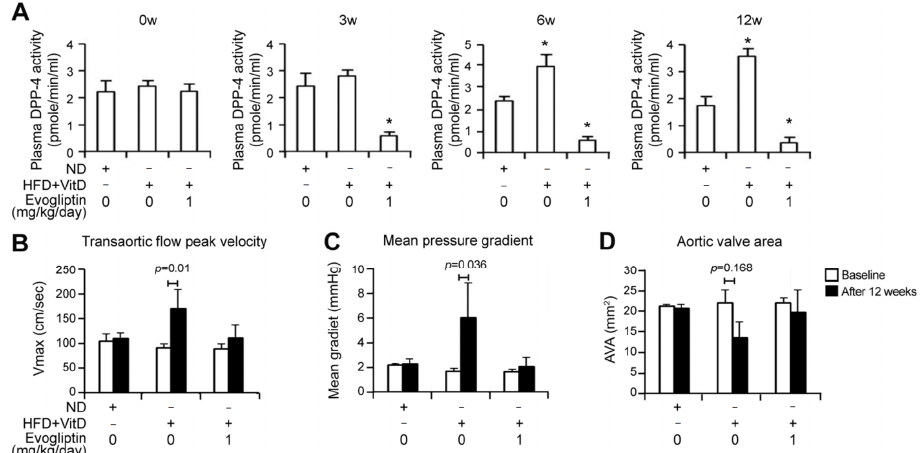
Figure 4. Effects of evogliptin on the aortic valve in a rabbit model of calcific aortic valve disease as determined by echocardiographic assessment. ( A ) Plasma DPP-4 activity was measured at baseline (0 weeks) and at 3, 6, or 12 weeks in the control group fed with a normal diet (ND), in rabbits fed a high-cholesterol diet and vitamin D2 supple- ments (HFD + VitD), and in evogliptin-treated rabbits on that same diet (HFD + VitD + evogliptin). Each group comprised ≥ 5 animals. ( B , C ) Aortic valve function was assessed by continuous-wave Doppler to measure the integral of the transvalvular flow and record the transaortic peak velocity (Vmax) ( B ) and mean pressure gradients ( C ) at baseline and at 12 weeks after treatment initiation in the control (ND), HFD + VitD, and HFD + VitD + evogliptin groups. Each group comprised ≥5 animals. ( D ) The standard continuity equation for echocardiography was used to measure the aortic valve area (AVA). Data represent the mean ± SD. p values were obtained using nonparametric matched data analysis and a Wilcoxon’s signed rank test.